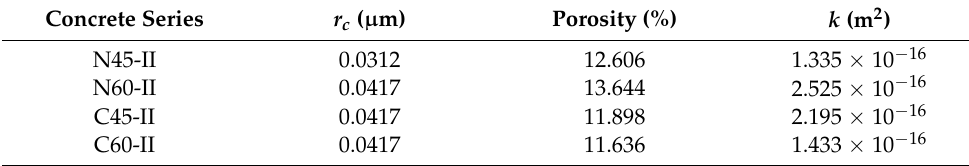
Figure 7. Pore distribution in R60-II series. Figure 7. Pore distribution in R45-II series. Table 6. Selected results of MIP